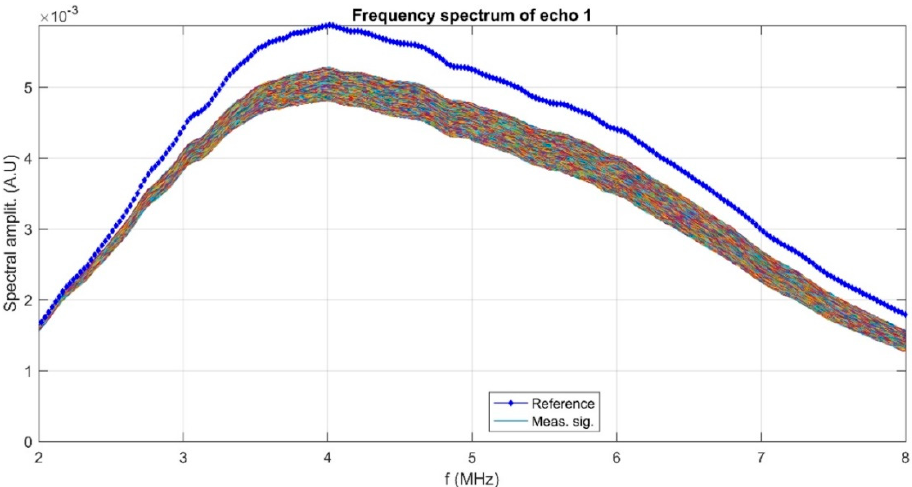
Figure 3. The frequency spectrum of the first transmitted echo. Reference fluid ( ♦ ) and all recorded echoes superposed (many colors).